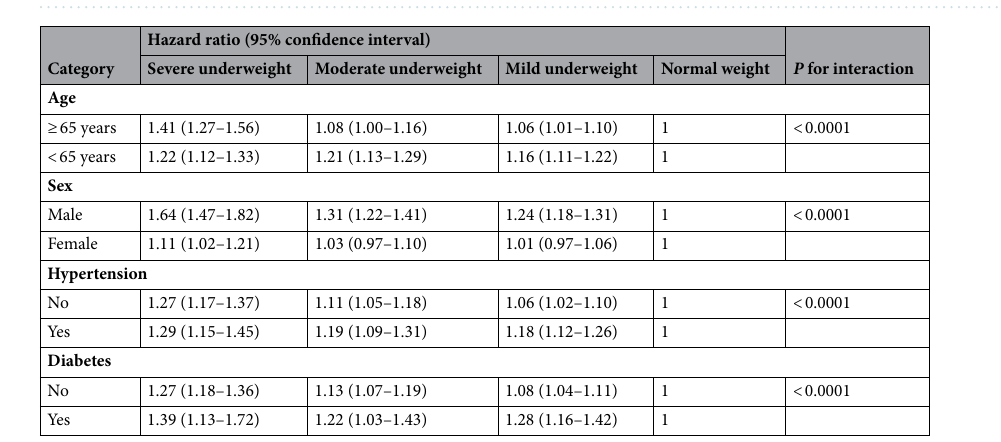
Figure 2. Kaplan–Meier estimates of fracture incidence according to underweight severity.